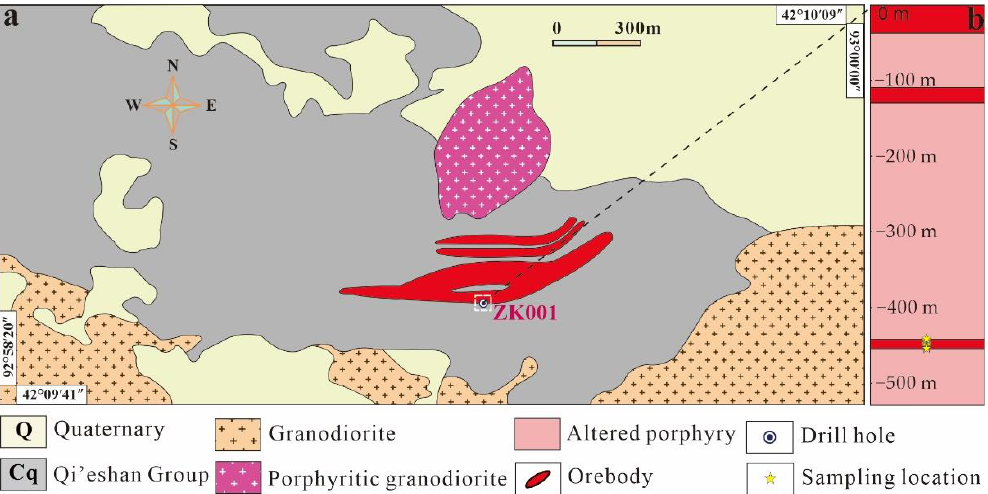
Figure 5. ( a ) Simplified geological map (modified from [22]) and ( b ) histogram of the ZK001 Drill hole of the Chihu porphyry Cu deposit.